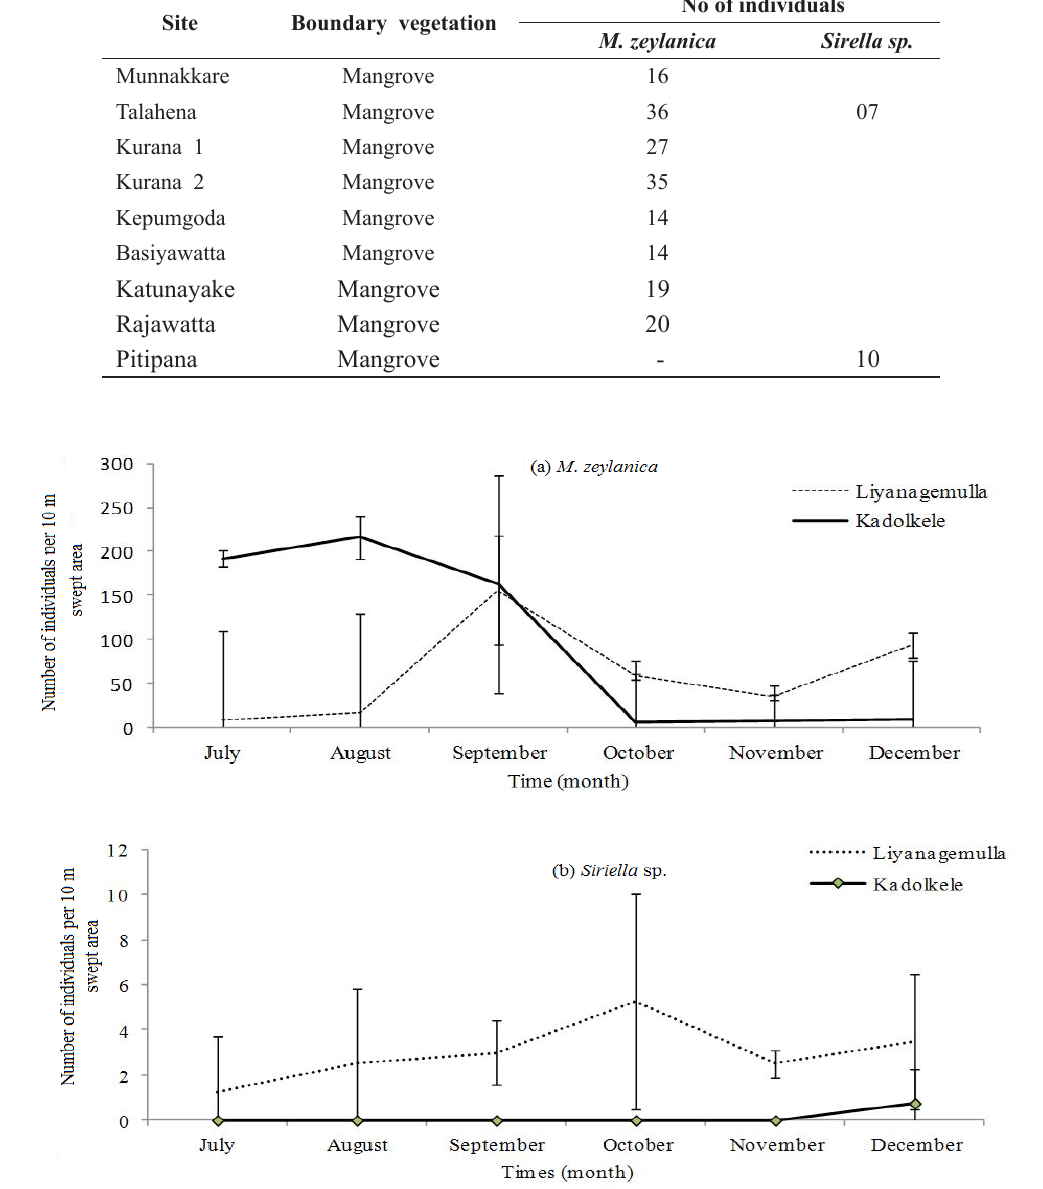
Table 3: Number of individuals of M. zeylanica and Sirella sp. collected from different study sites (Except temporal distribution survey).